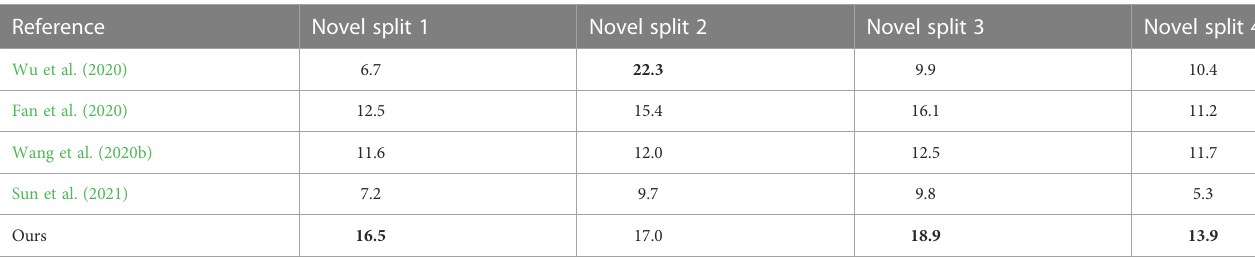
TABLE 2 FSIP52 novel classes ’ mean average precision (mAP) in 13-way 10-shot settings.